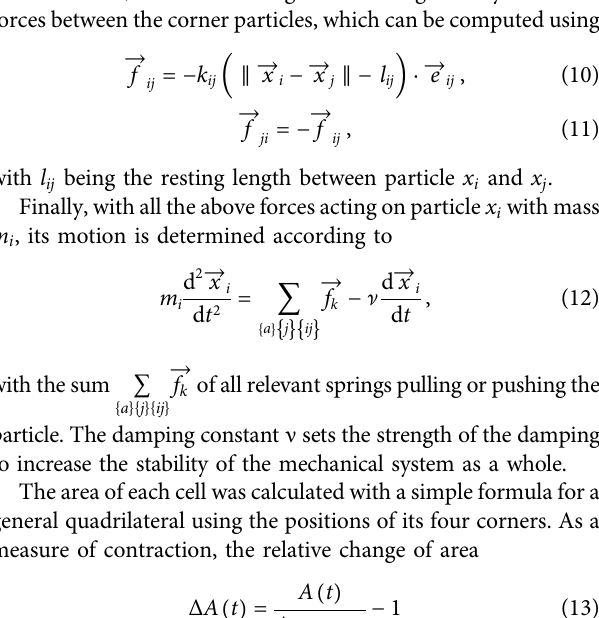
Placed on a regular lattice, one mechanical cell is made up of four particles x i at the corners connected by structural springs and two sets of orthogonal springs connecting the centre of → mass x cm to each side of the cell (see Figure 3 ). The springs in the middle of the cell are called axial springs , of which one is made to be active (red). Here it is important to point out that one cell in the electrical model corresponds to one cell in the mechanical mass-spring system. For setting the fi bre orientation through the active axial spring, the orientation parameter η ∈ [ 0 , 1 ] has been introduced, with which the four points of attachment q i can be computed easily. This parameter can be set individually for each cell, so that various fi bre orientations can be modelled.